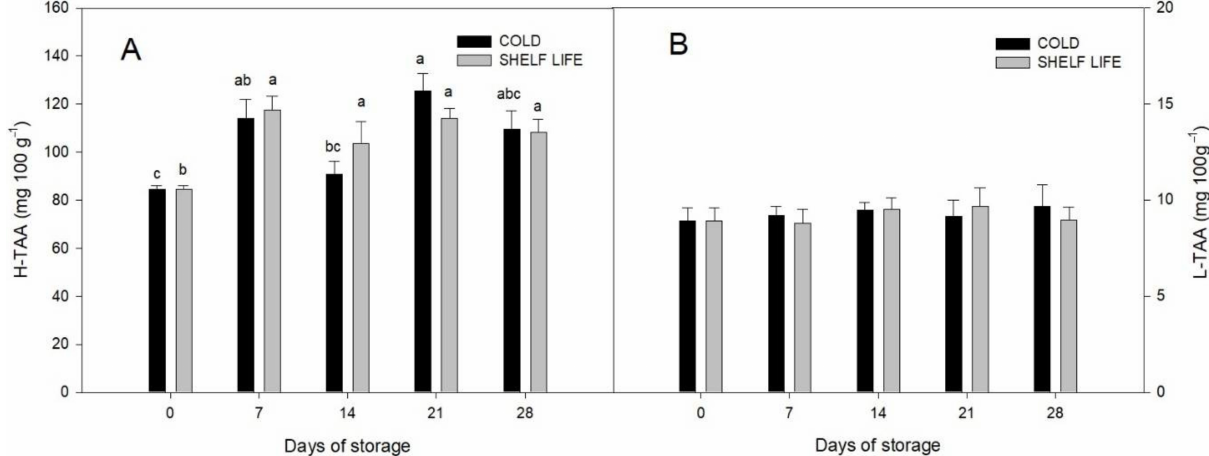
Figure 4. Changes in H-TAA ( A ) and L-TAA ( B ) during storage under cold and shelf life conditions of cactus pear fruit. Data are the mean ± SE ( n = 6). Tukey test’s at a 95% confidence level is shown. Different letters (a,b,c) indicate significant differences ( p < 0.05) during each storage